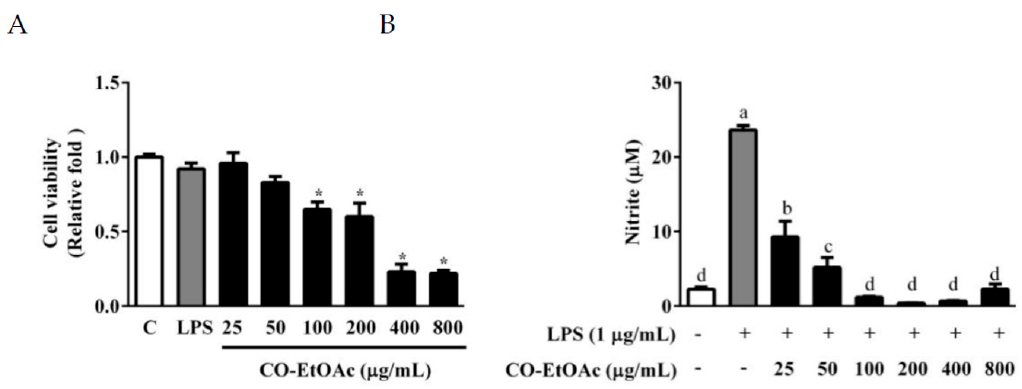
Figure 2. The effects of different concentrations of CO-EtOAc on cell viability ( A ) and nitric oxide (NO) production ( B ) in RAW264.7 cells. RAW264.7 cells were treated with various concentrations of CO-EtOAc (25, 50, 100, 200, 400, and 800 μ g/mL) in the presence or absence of lipopolysaccharide (LPS) (1 μ g/mL) for 24 h. ( A ) Cell viability was measured using the WST-1 assay, and the ( B ) NO production in the cell culture supernatants determined using the Griess assay. The results are expressed as means ± standard deviation (SD) from three independent experiments. For cell viability, * indicates p < 0.05 when compared to the dimethyl sulfoxide (DMSO) control group. For NO production: values with different letters indicate significant difference ( p < 0.05).